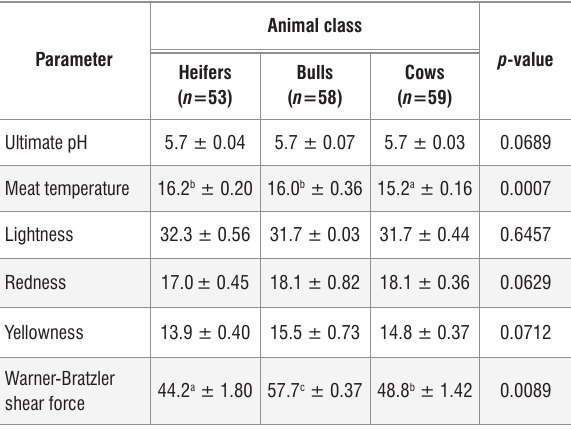
Least square means and standard errors of beef quality parameters from cattle by